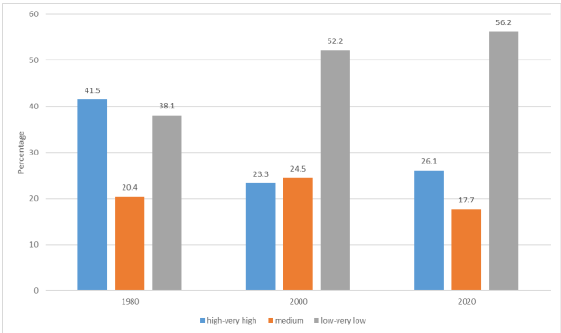
Table 3: Summary of the values of VCI for high to very high, medium, and low to very low vegetation cover and its distribution with elevation from 1980 to 2020.